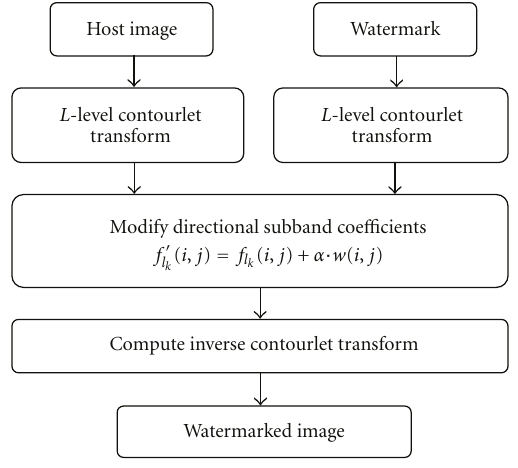
Figure 6: Embedding algorithm.